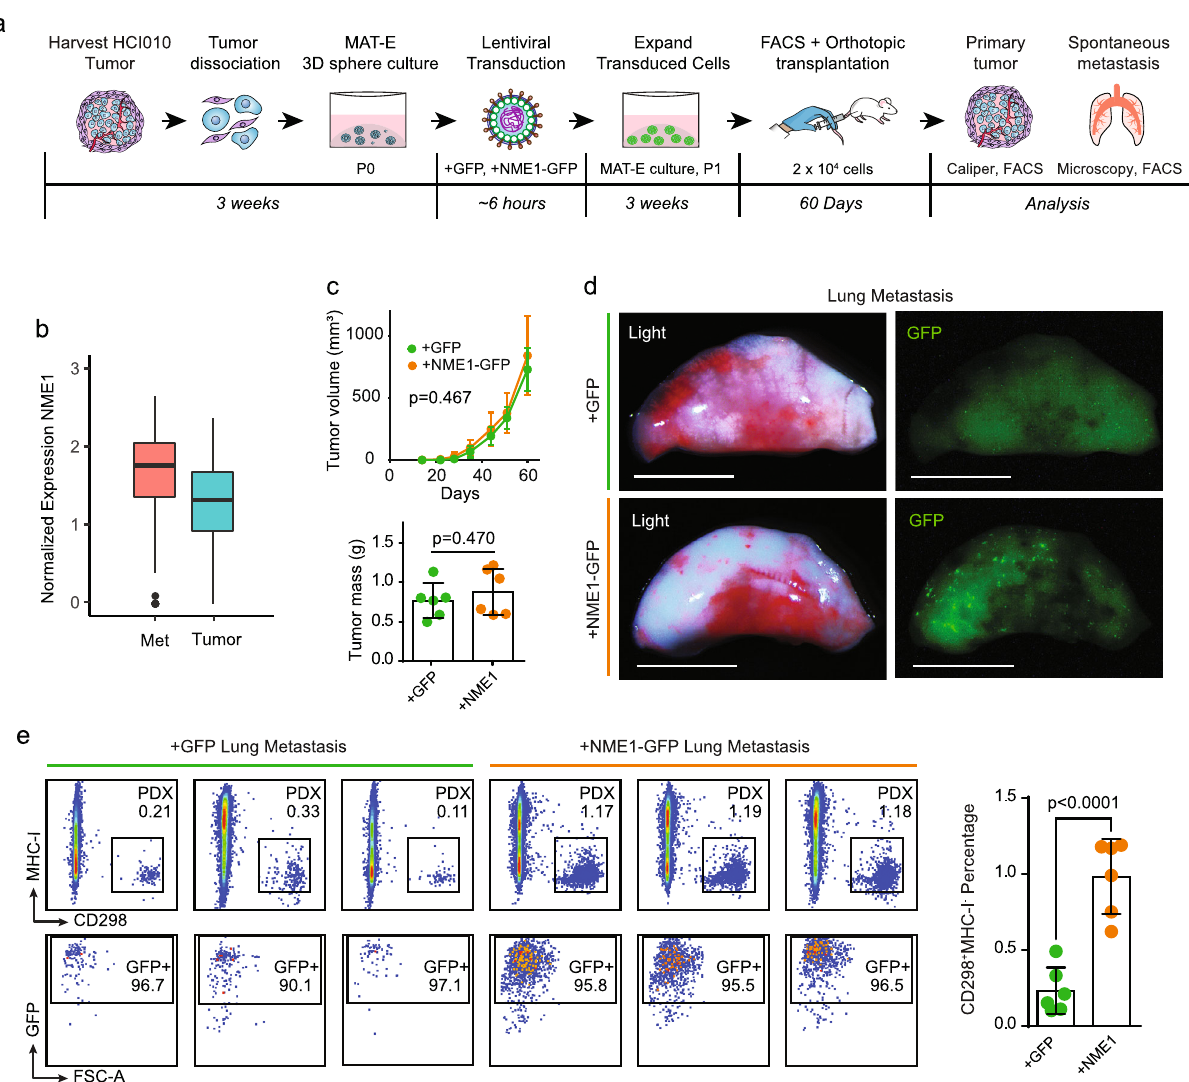
Fig. 7 NME1 promotes lung metastasis from patient tumor cells. a Schematic of experimental work fl ow to investigate the effect of NME1 overexpression on spontaneous metastasis from cultured PDX tumor cells. b The box plot shows normalized gene expression of NME1 in metastatic (red, n = 435 cells) and primary tumor cells (blue, n = 684 cells). The lower and upper hinges correspond to the fi rst and third quartiles, and the midline represents the median. The upper and lower whiskers extend from the hinge up to 1.5 * IQR (inter-quartile range). Outlier points are indicated if they extend beyond